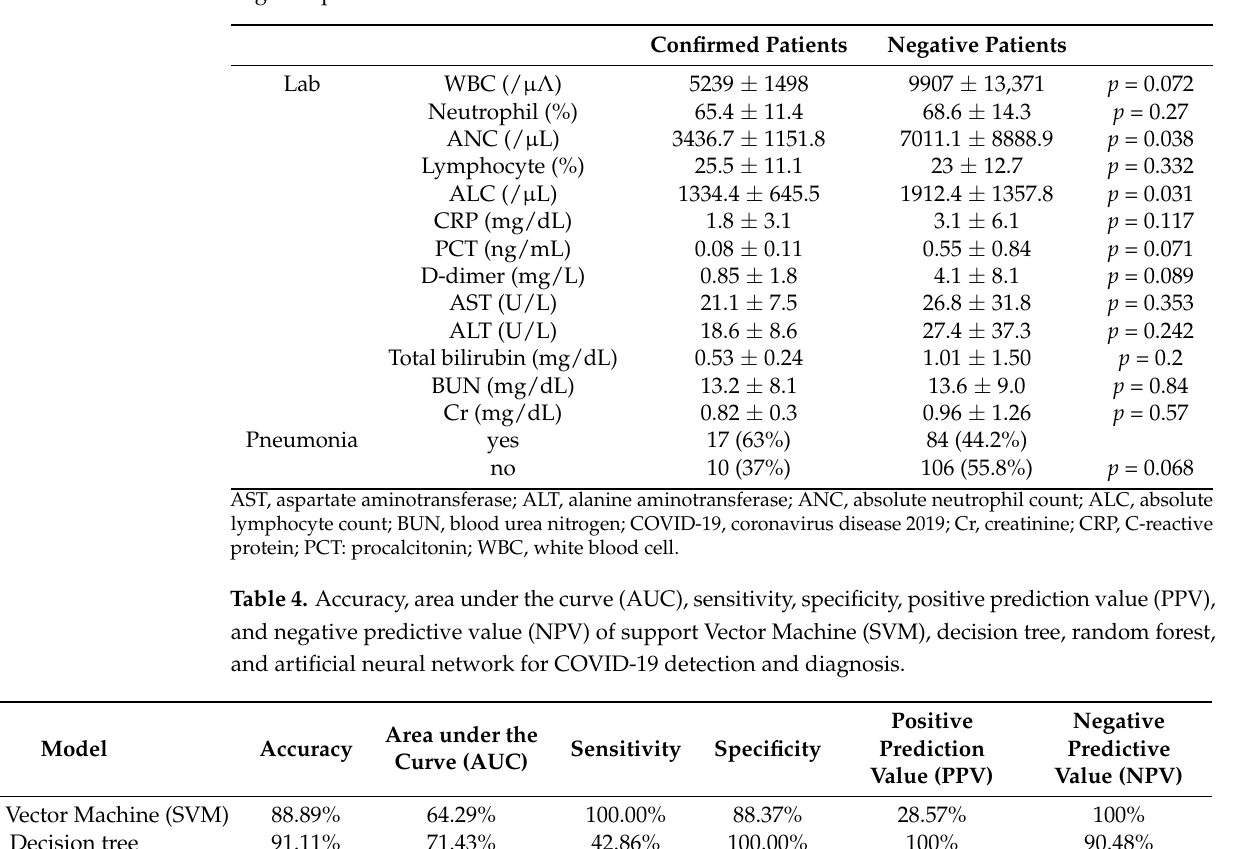
Table 3. Laboratory and radiological findings of confirmed COVID-19 patients and COVID-19- negative patients on admission.